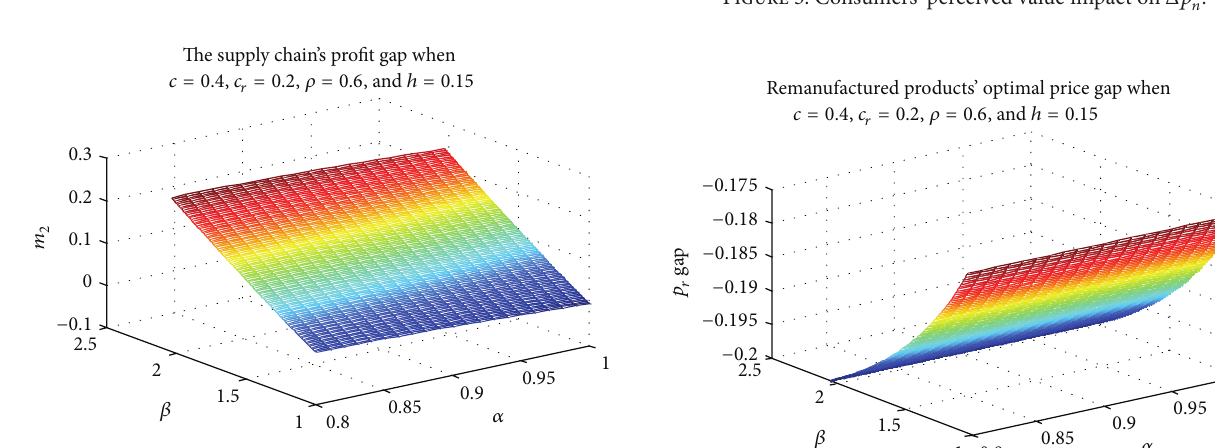
Figure 1: Consumers’ perceived value impact on 𝑚 ∗ 1 .